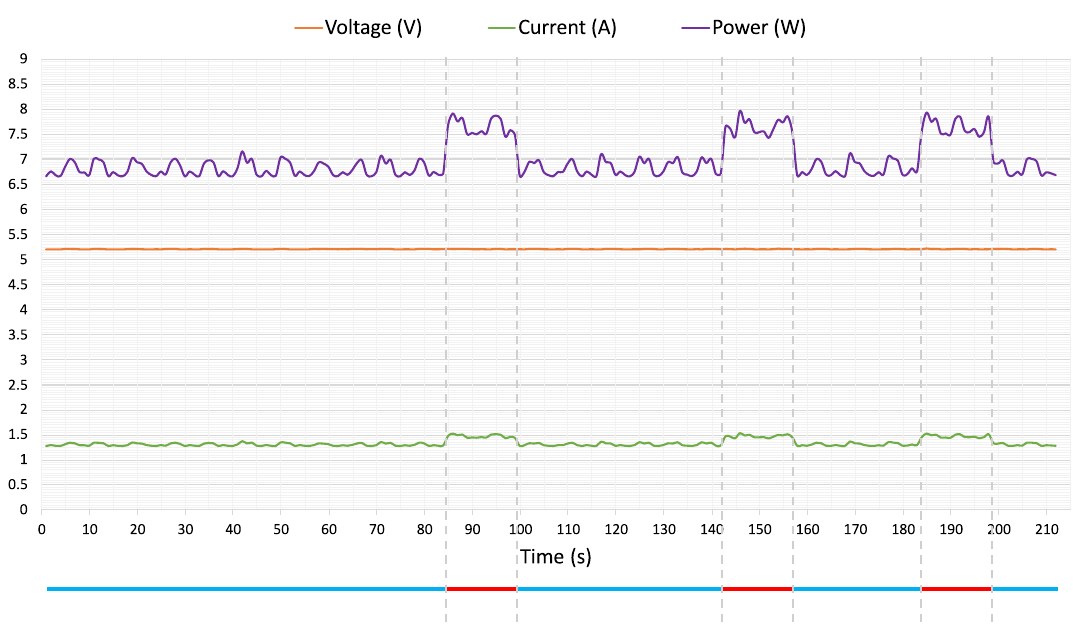
Figure 6. Power consumption of the system during idle and under full load. A digital multimeter was connected to the system’s power input to measure the voltage (V) and current (I) at a frequency of 1 Hz. Power consumption was then calculated as P = V × I. Vertical dashed lines indicate the starting and ending point of time of system load. Colored lines at the bottom of this figure indicate in which state the system was: blue—idle; red—full load. Full load refers to when all 4 pumps are running at